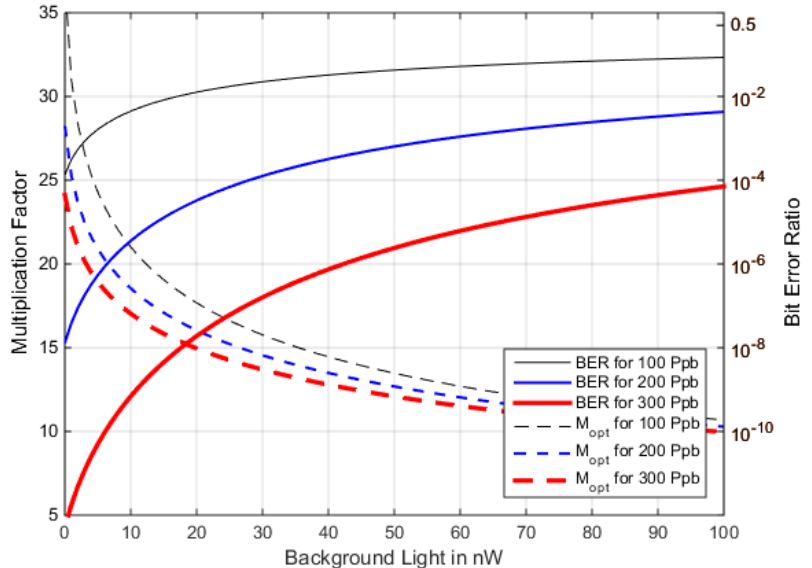
Figure 14. BER and M opt over P BGL at a P Rx of 100/200/300 Ppb, for BGL from 0 to 100 nW (no I DM to visualize the effect of BGL only).